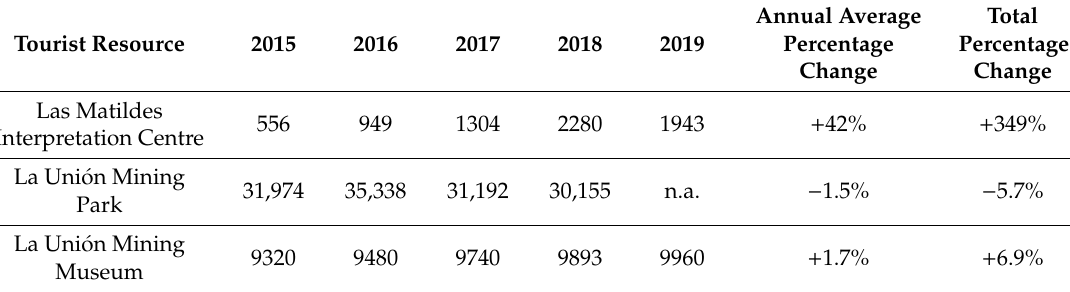
Table 6. Recent evolution of the number of visitors.